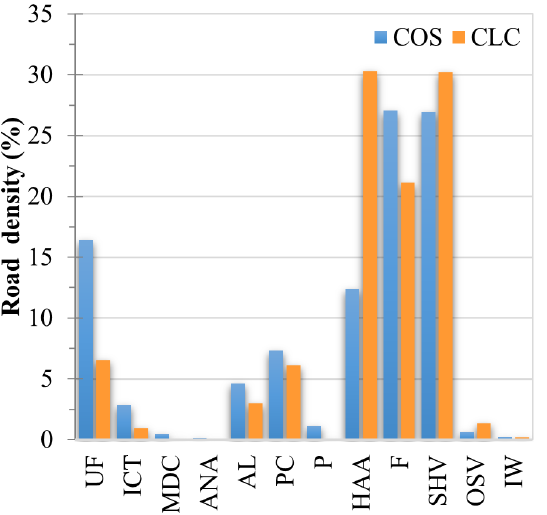
Figure 7. Density of roads by LUC class of CLC and COS data (see LUC legend in Fig. 2).